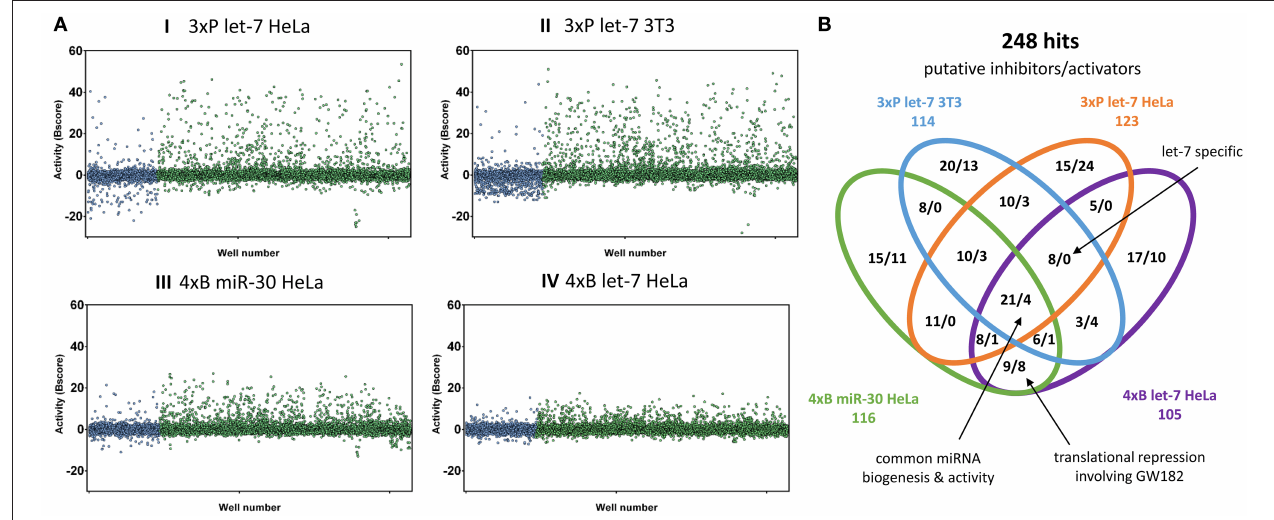
FIGURE 3 | Primary HTS results. (A) Overview of all results. Graphs depict normalized reporter activities for all 12,816 compounds. In blue are shown compounds from the bioactive set, while the diversity compound set is shown in green. (B) Venn diagram depicting 248 compounds most influencing the indicated reporters. Shown are counts of putative inhibitors (increasing reporter activity) and stimulators (reducing reporter activity).